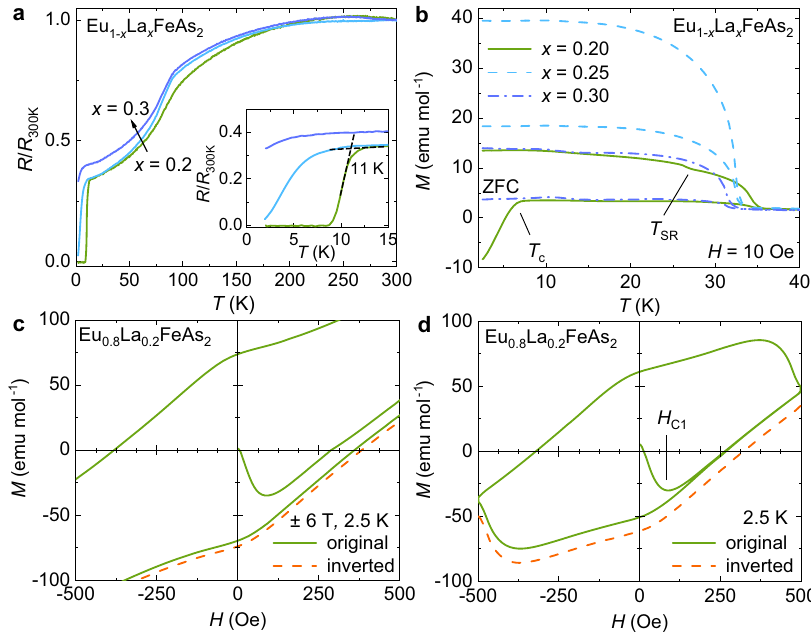
Fig. 3 Physical properties of overdoped Eu 1 − x La x FeAs 2 . a , b Normalized resistivity and magnetization against temperature, respectively. c , d Magnetization against the fi eld for different fi eld intervals of − 6 to 6 T and − 500 to 500 Oe, respectively, obtained at 2.5 K. The inset in a is a close view of the superconducting transition. Parts of the inverted M – H curves, dashes in c and d , are for comparison with the original